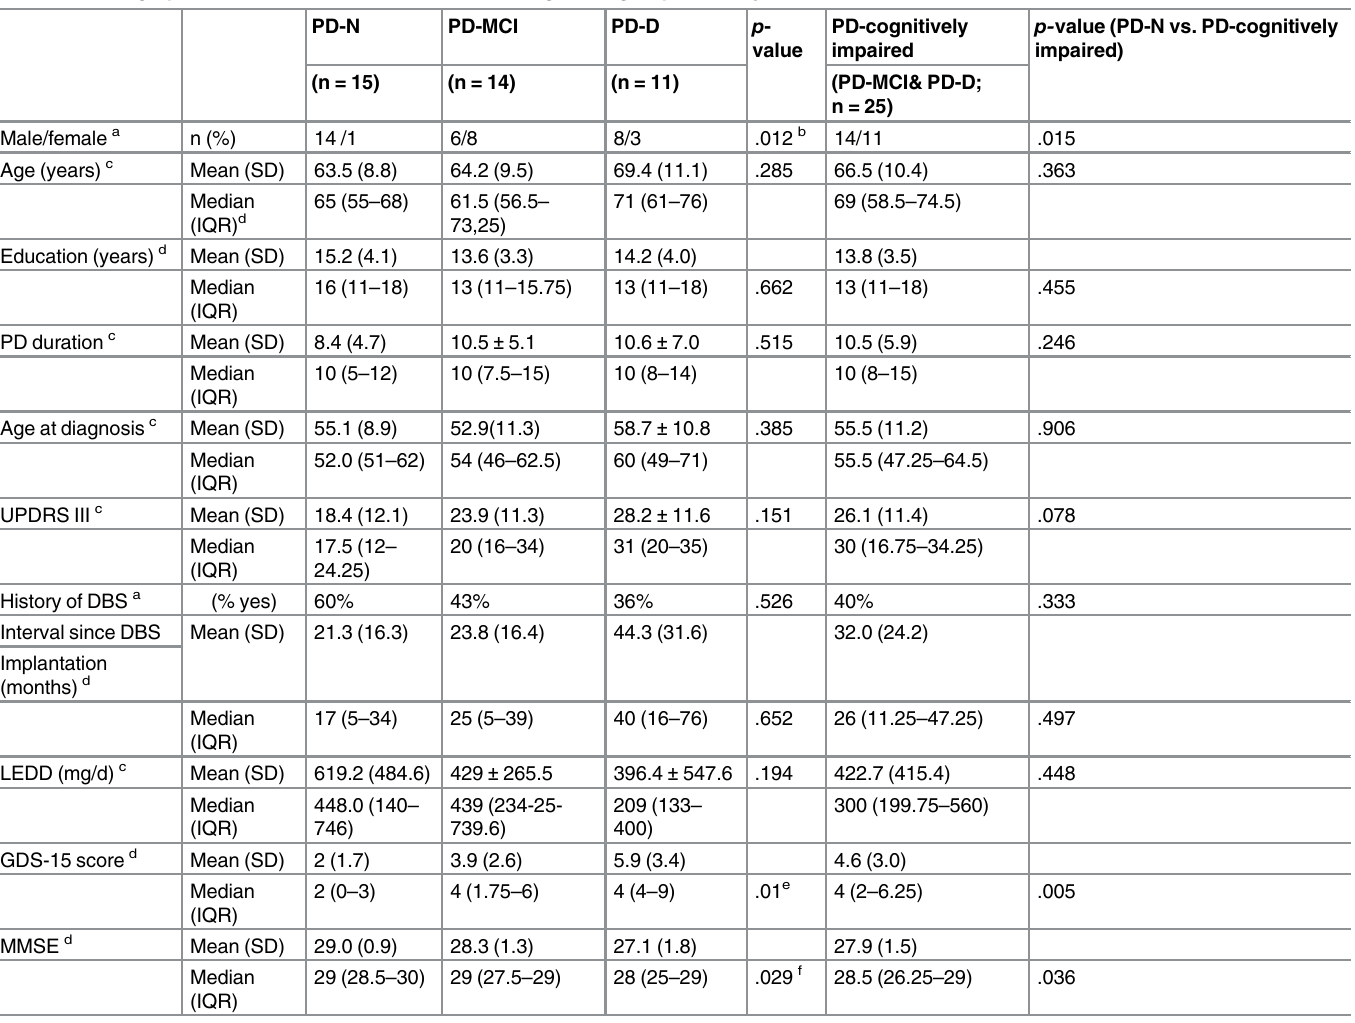
Table 3. Demographic and clinical characteristics of all diagnostic groups in study